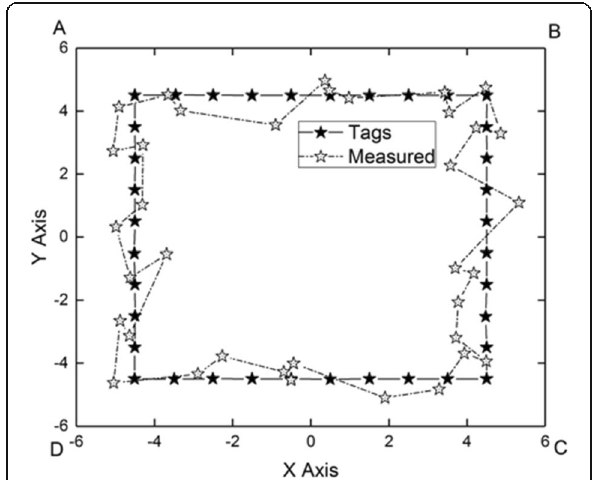
Fig. 8 2D indoor localization configuration. In this experiment, there are 36 targets supposed to localize in two-dimensional space, which are represented by black pentagonal stars. Then, we achieve 36 promising position measured by communication method mentioned in Section 4. The measured results are